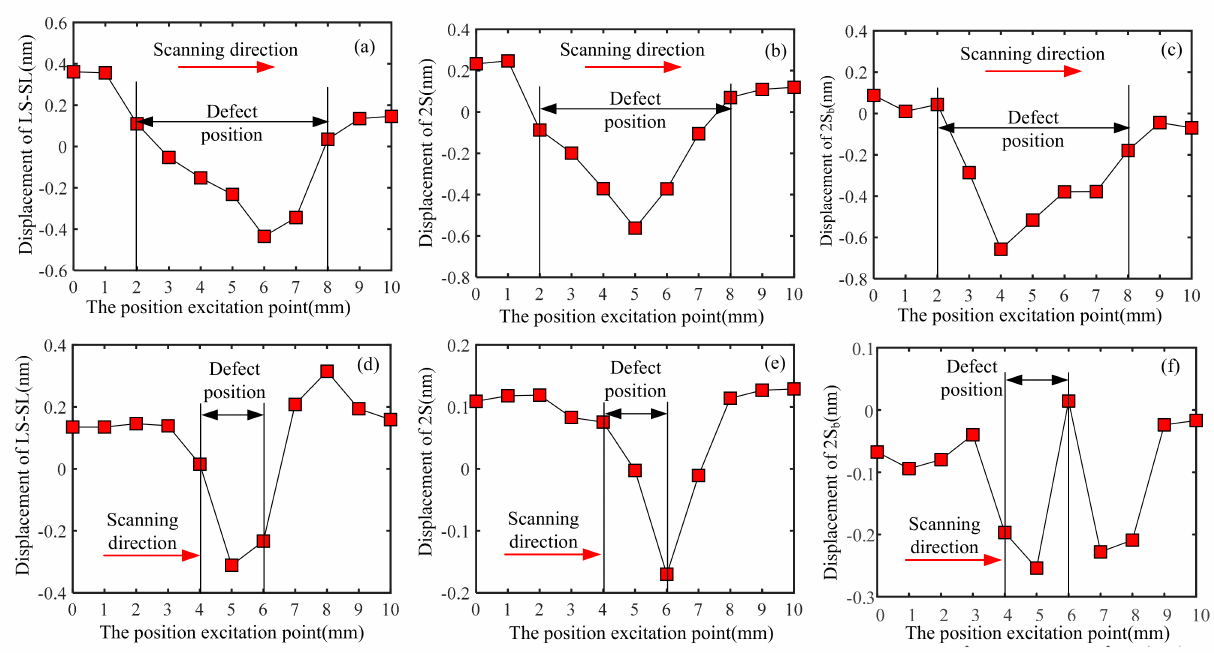
Figure 10. Variation of displacement of ultrasonic waves in different modes after interacting with defects of different sizes. ( a ) W = 6 mm, LS-SL, ( b ) W = 6 mm, 2S, ( c ) W = 6 mm, 2S b , ( d ) W = 2 mm, LS-SL, ( e ) W = 2 mm, 2S, and ( f ) W = 2 mm, 2S b